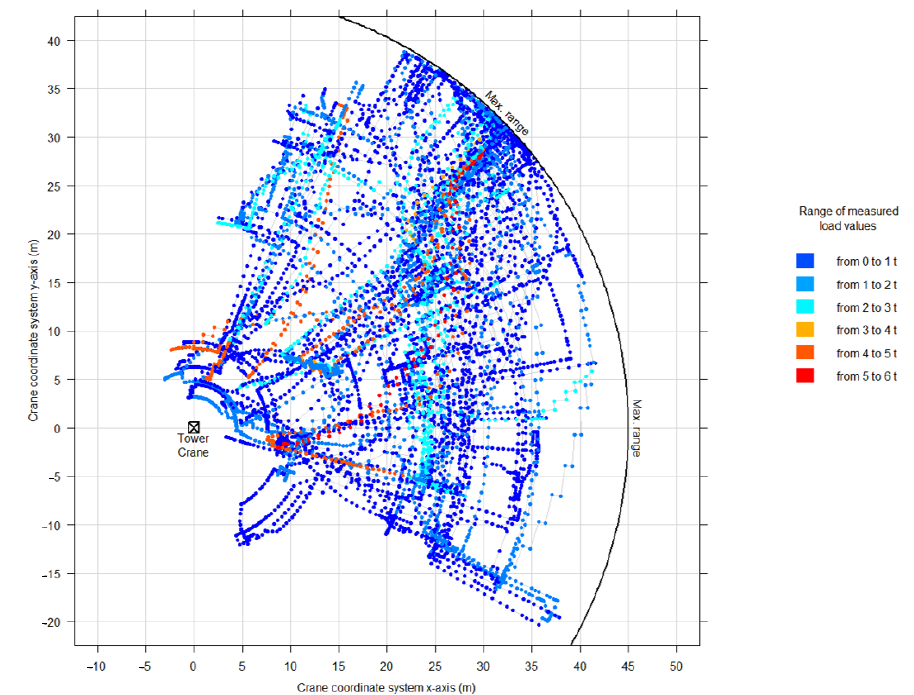
Figure 2. Plane projection of the crane hook’s